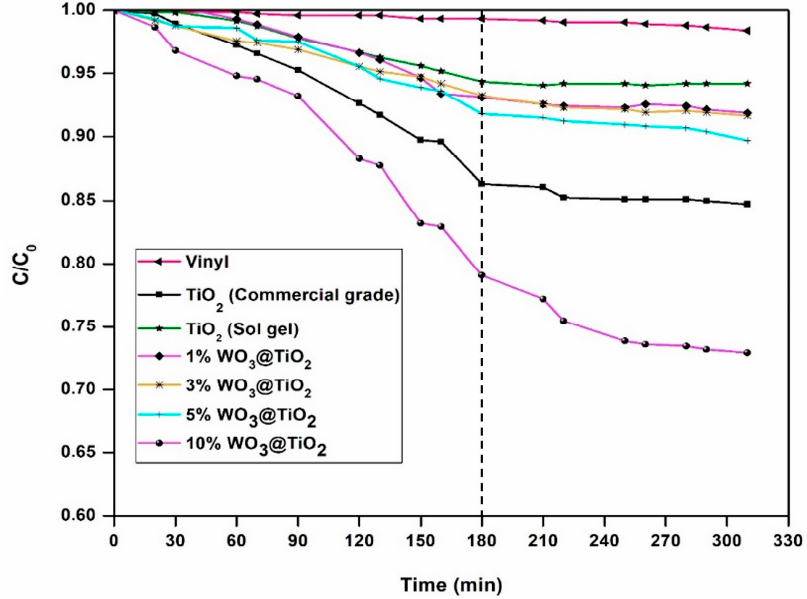
Figure 10. Photocatalytic degradation of MB by the substrates coated with the vinyl/metal oxide films. Table 3. Number of colonies and kinetic constants of samples treated by seawater for 7